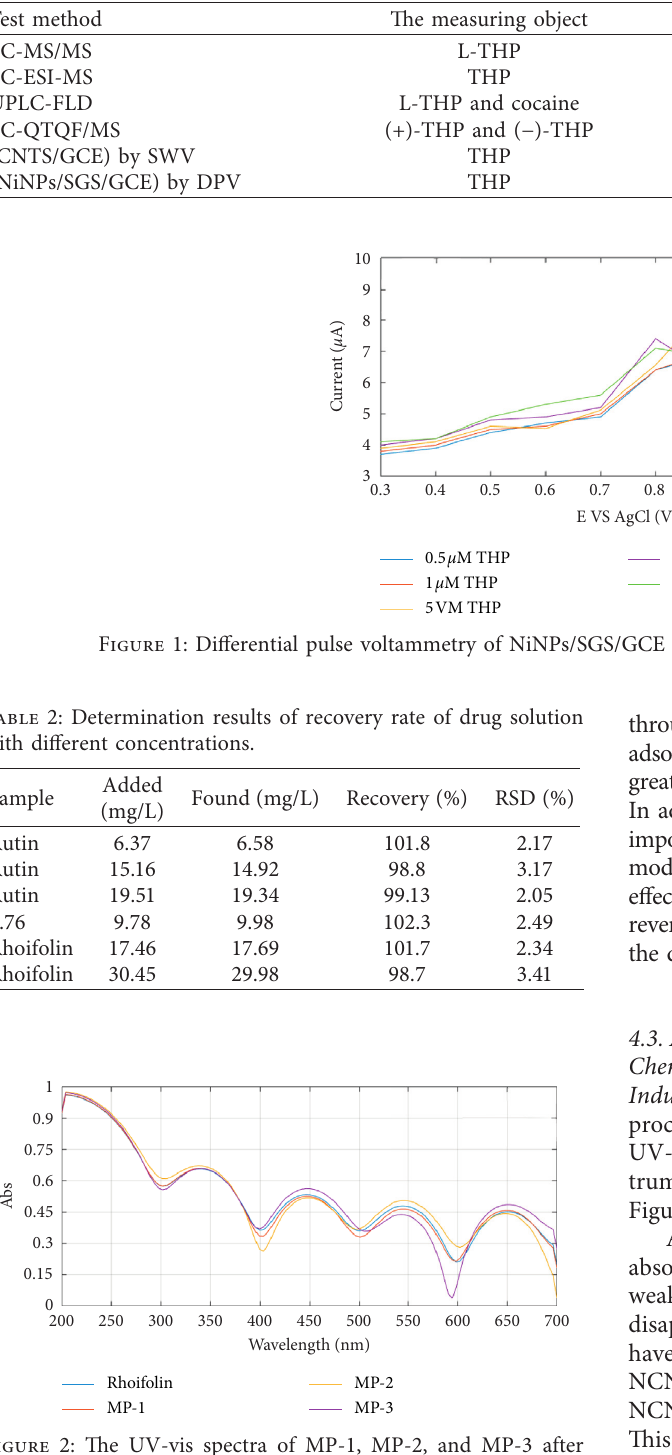
Table 1: Comparison of electrochemical method with other THP determination methods.